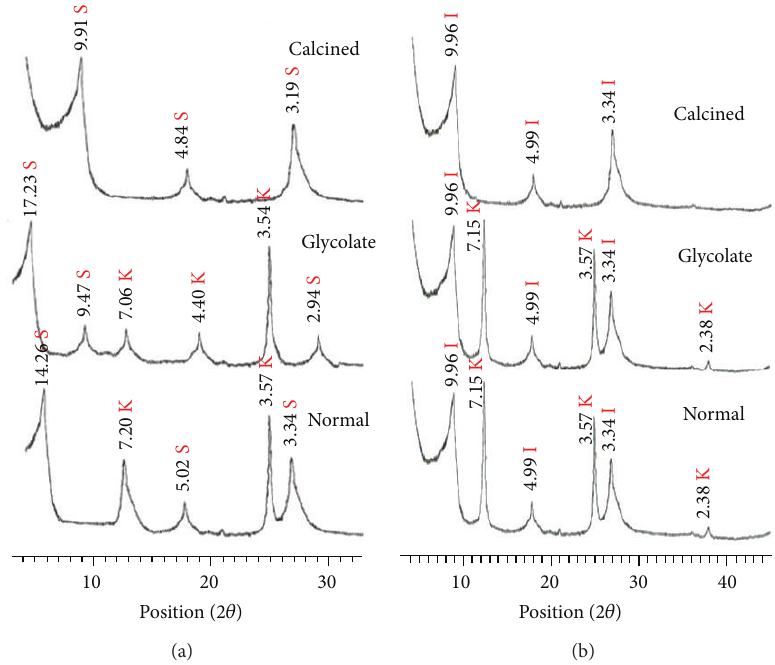
Figure 2: X-ray diffraction patterns of (a) RBC and (b)